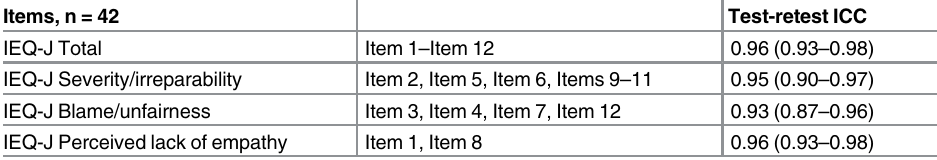
Table 6. Intraclass correlation coefficient of Japanese version of the Injustice Experience